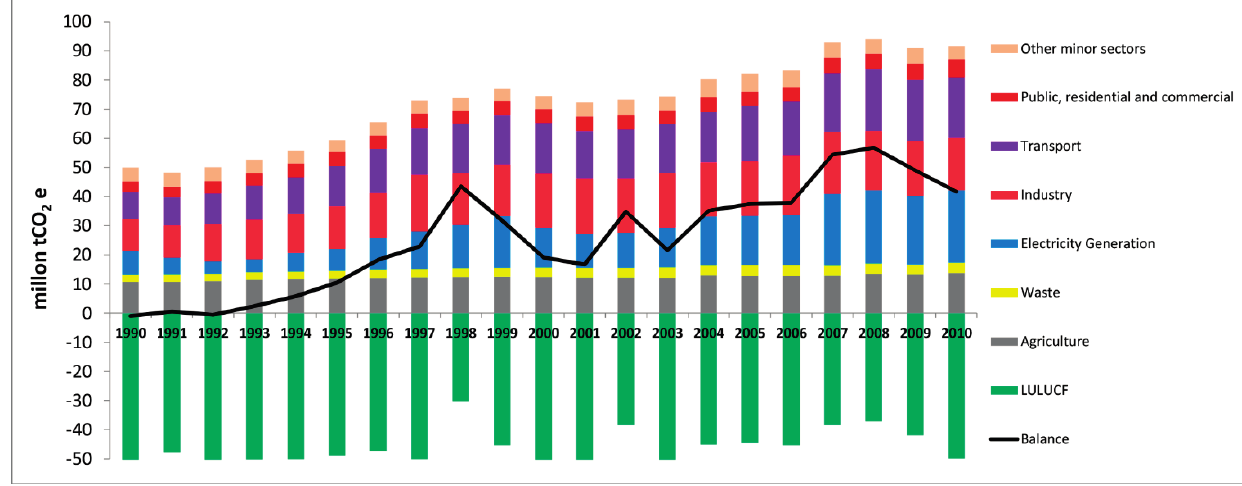
Figure 1. Chilean national GHG inventory by sector [1]. The blue bar is the electricity generation sector which is analysed in this